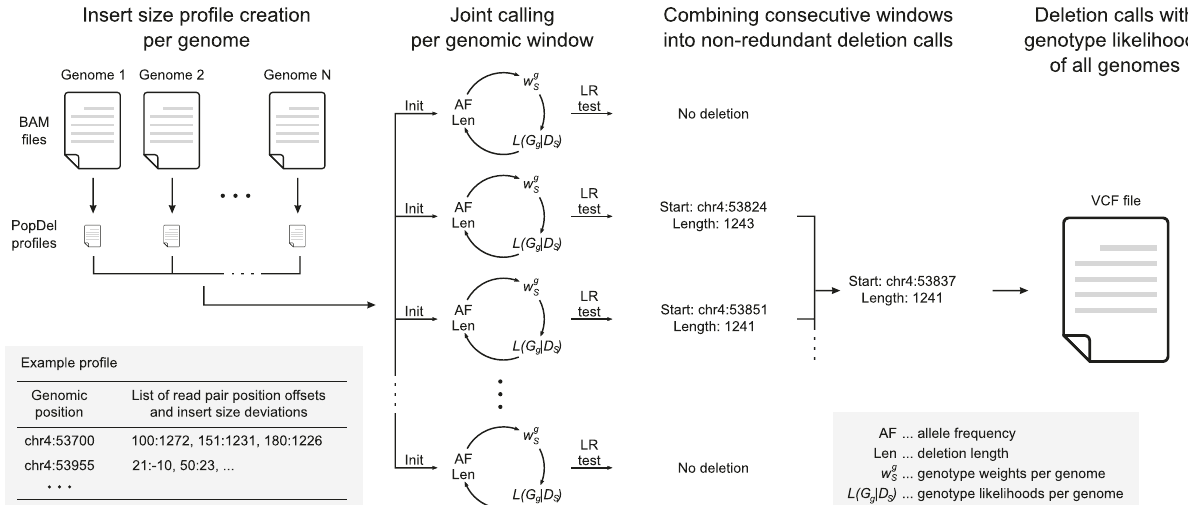
Fig. 1 Overview of the approach implemented in PopDel. First, the BAM fi le of one individual at a time is reduced into a small pro fi le. The pro fi les of all individuals are processed together by sliding a window (of size 30 bp by default) over the genome and assessing the likelihood of each window to overlap a deletion in any individual. Sizes and allele frequencies of the deletions are estimated iteratively. Consecutive windows are combined into a single variant call and genotypes of all individuals are output to a VCF fi le. Init initialization, AF allele frequency, Len deletion length, w g L ( G g | D S ) genotype likelihoods per genome, LR likelihood ratio.